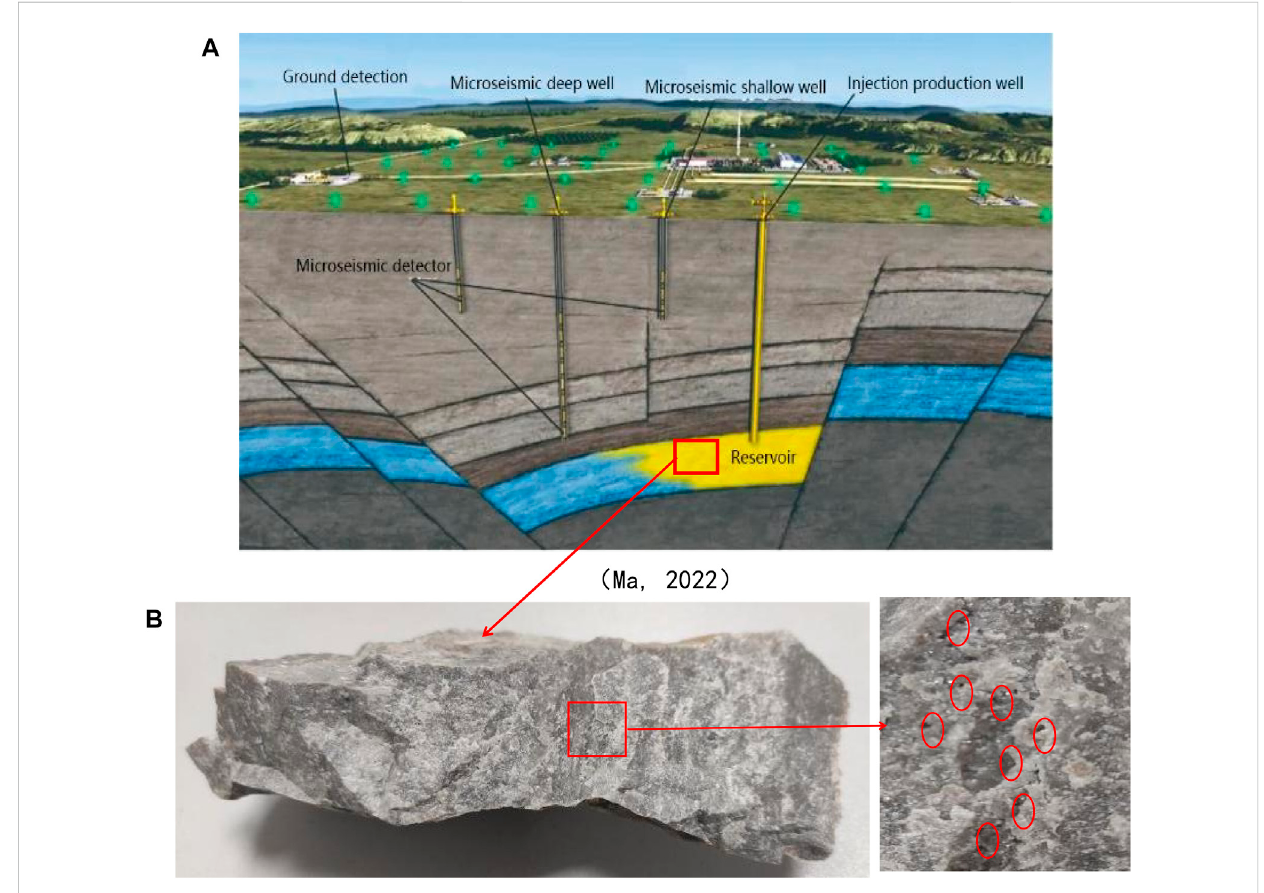
FIGURE 4 Characteristic change of multi cycle injection and production reservoir in X UGS. (A) : reservoir, (B) : porous.